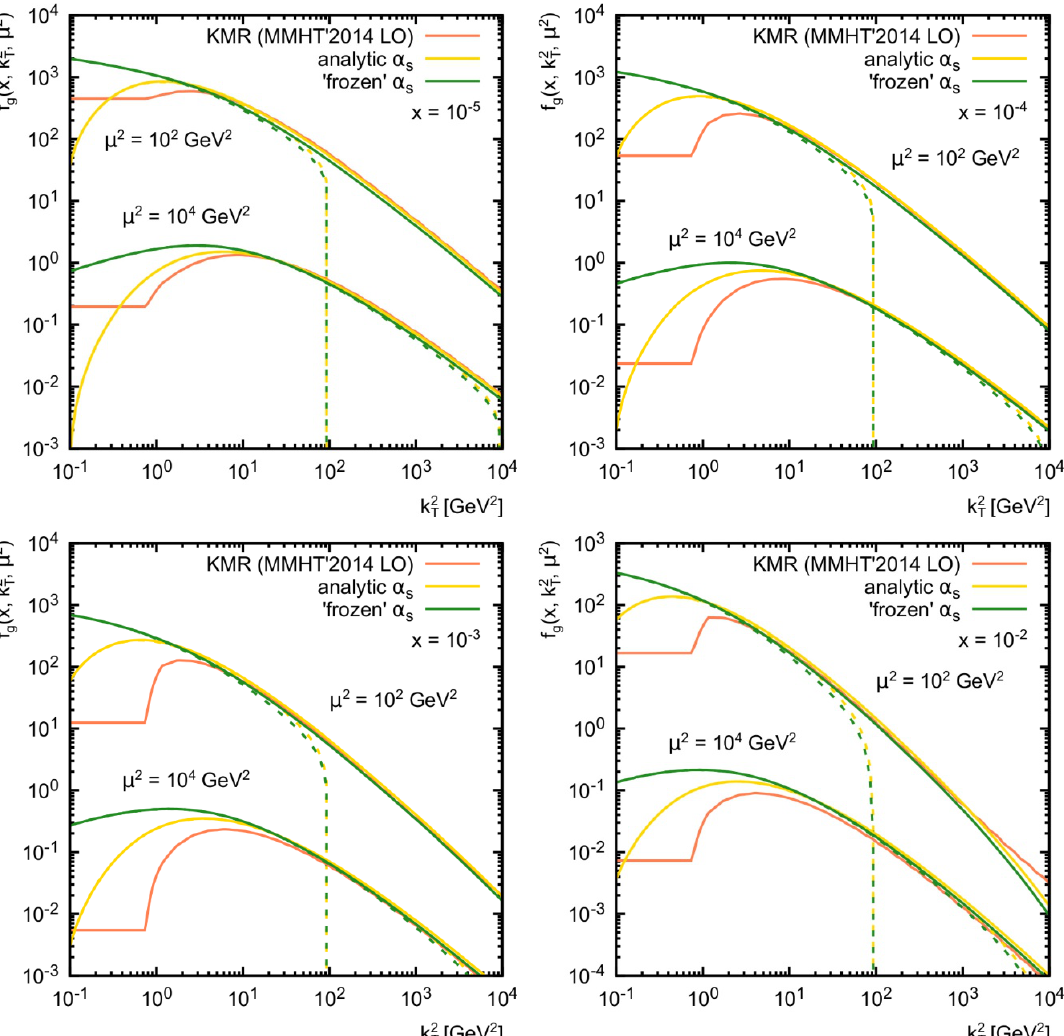
Figure 2 . The TMD gluon densities in a proton calculated as a function of the gluon transverse momentum k 2 at di(cid:11)erent values of longitudinal momentum fraction x and hard scale (cid:22) 2 . The T integral formulation of the KMR approach is used. The solid green and yellow curves correspond to the results obtained with \frozen" and analytic QCD coupling constant with angular ordering condition, while corresponding dashed curves represent the results obtained with strong ordering condition. The red curves correspond to the TMD gluon distributions calculated numerically in the traditional KMR scenario, where the conventional parton densities from standard MMHT’2014 (LO) set are used as an input.